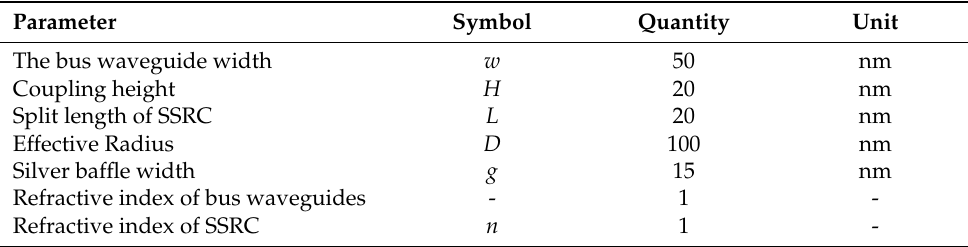
Table 1. Summary of the simulation calculation parameters of the